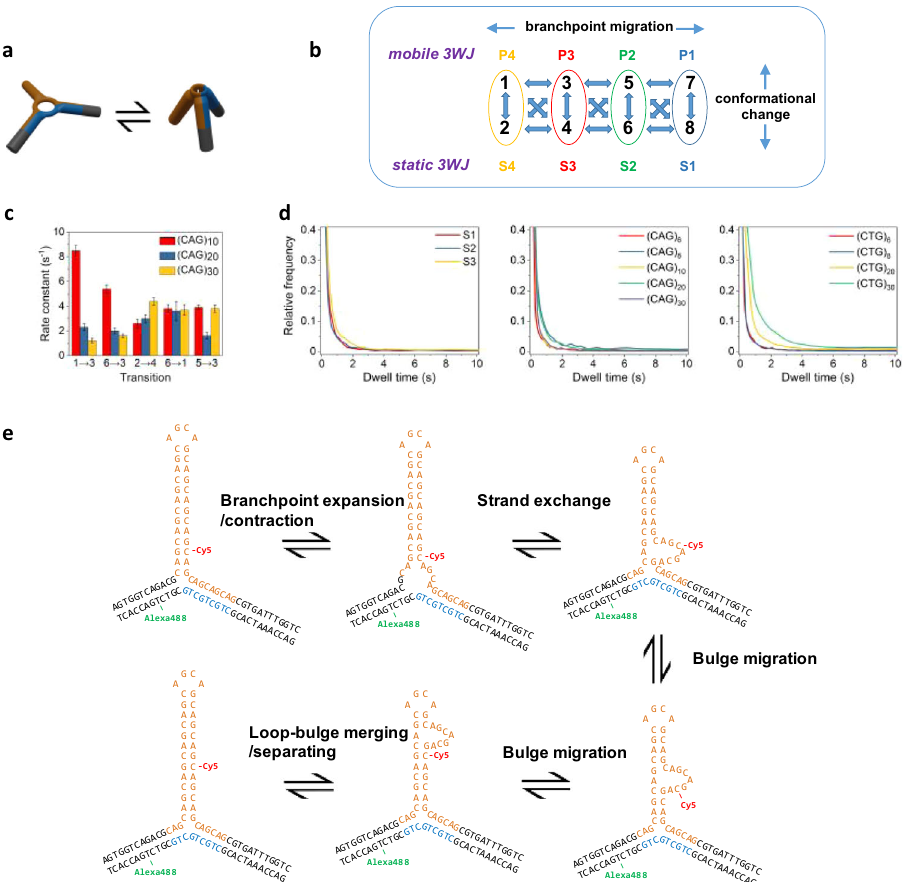
Fig. 4 Conformational and branch migration dynamics in slip-out 3WJs. a 3WJs with hairpin slip-outs can undergo conformational change, attributed to branchpoint rearrangement (e.g., expansion/contraction). b Kinetic scheme showing the eight possible FRET states as a result of the two conformations for each positional isomer. c Selected rate constants for mobile 3WJs with 10, 20, or 30 repeats in the slip-out. Error bars represent the standard error from non-linear curve fi tting (see Methods for details). d Cumulative dwell times histogram for static 3WJs (left), and mobile 3WJs with CAG (middle) or CTG (right) slip-outs. e Model of branch migration in 3WJs with trinucleotide repeats in a slip-out and in the duplex. Measurements made at 20 °C in a buffer containing 1 mM MgCl 2